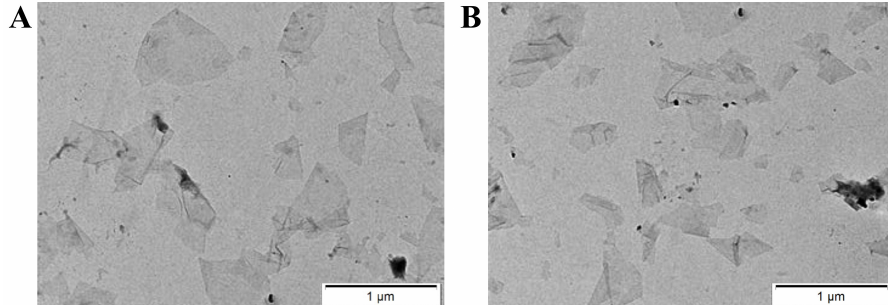
Figure 1. TEM images of GO ( A ) and nanosensor ( B ).